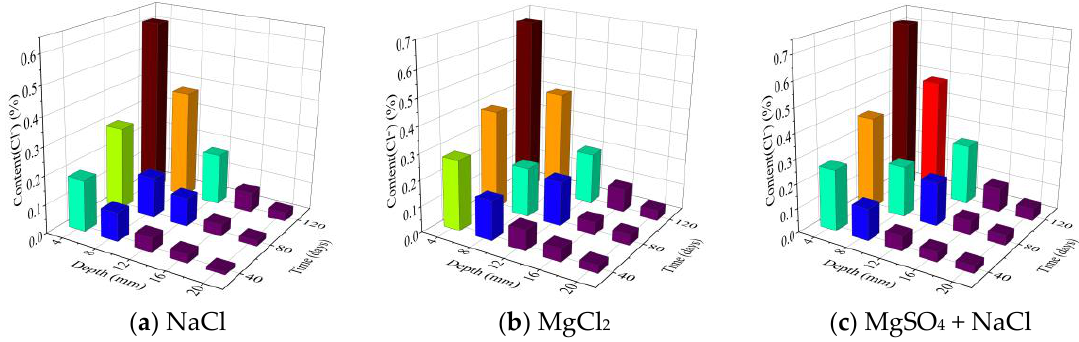
Figure 10. Cl − Content in MK Concrete.